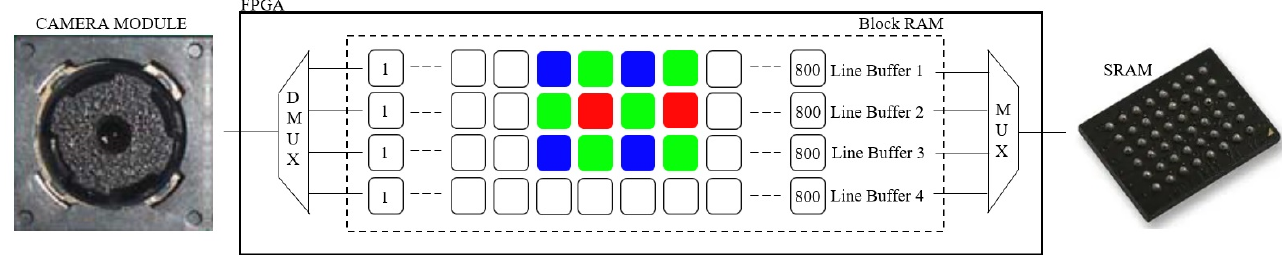
Figure 5. FPGA real-time image processing block. The camera module was set to the raw-RGB image data format. Each acquired pixel had a 10-bit intensity value of either red, green, or blue color. Half of all of the pixels in the image sensor were green. Therefore, the spatial resolution of green pixels was twice that compared to the blue pixels’ or red pixels’ spatial resolution. We interpolated the missing green pixels to obtain an 8-bit green monochrome image that can be approximated to a grayscale image, which we would obtain from an 8-bit monochrome grayscale image sensor. To interpolate the missing green pixels, we used an edge-directed bilinear interpolation. Figure 6a, Equations (1) and (2) show the pixels involved in an edge-directed bilinear interpolation of the missing green pixels. Green color interpolation was calculated at every red pixel position and at every blue pixel position. The image sharpness value was calculated at every green pixel position as a blue-gradient and red-gradient calculation. By doing this, the two image-processing operations were interleaved on a single image frame. To the best of our knowledge,